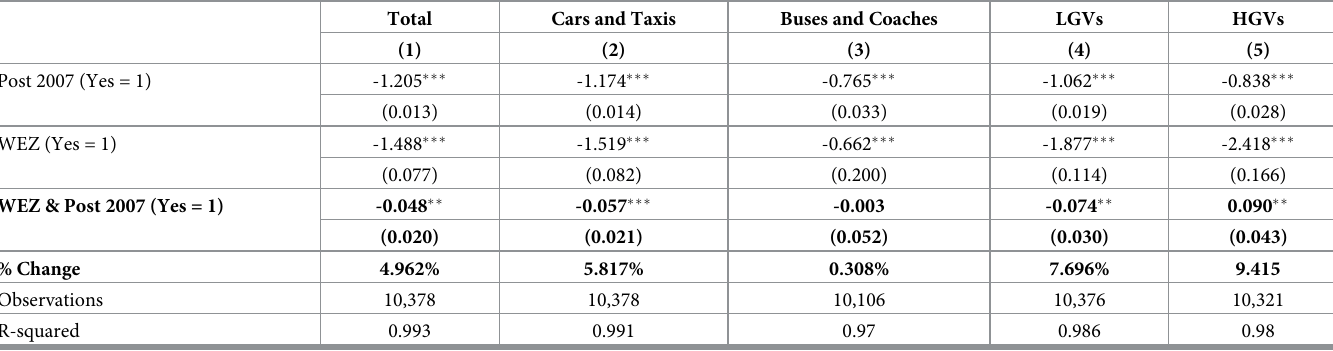
Table 1. DiD estimates associated with the analysis of the introduction of the WEZ using logs.